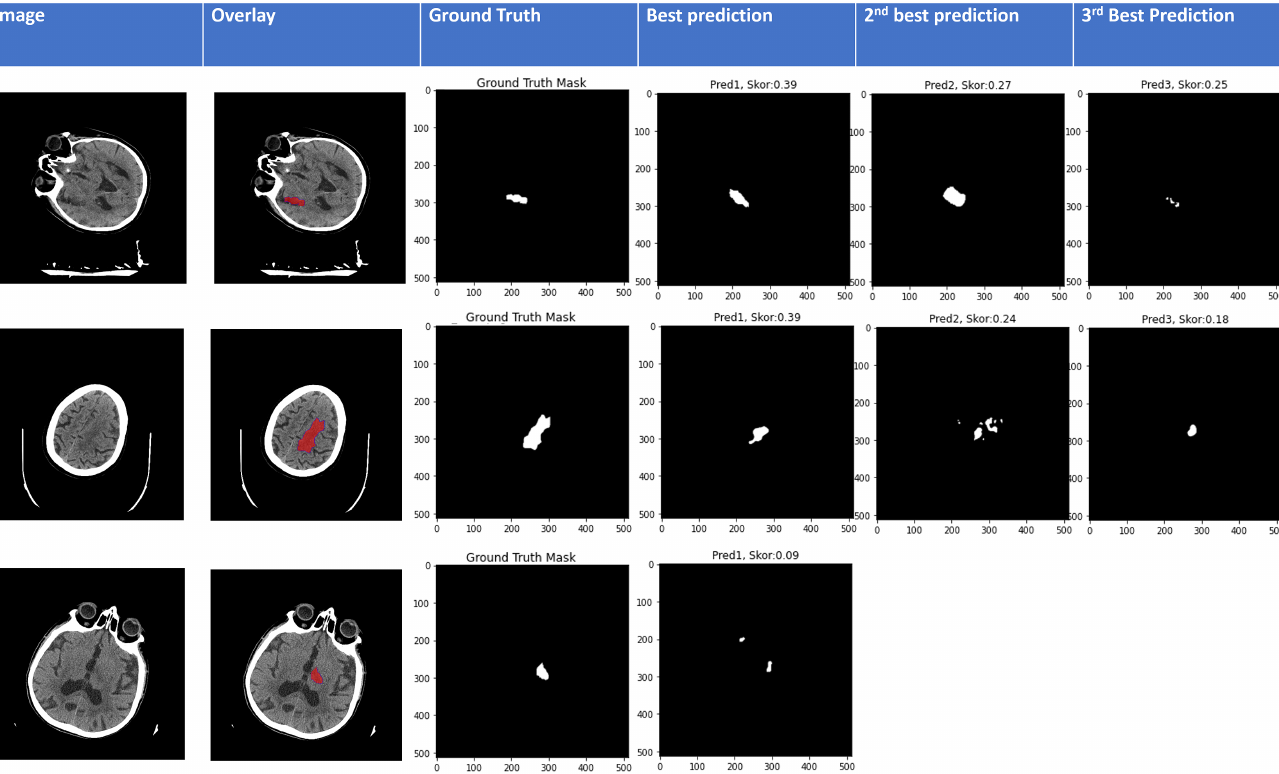
Figure 7. Top IoU scores of 3 images were demonstrated. All of the images are of the hyperacute ischemic stroke cases. Imaging findings that are hard to catch, even for the radiologist.